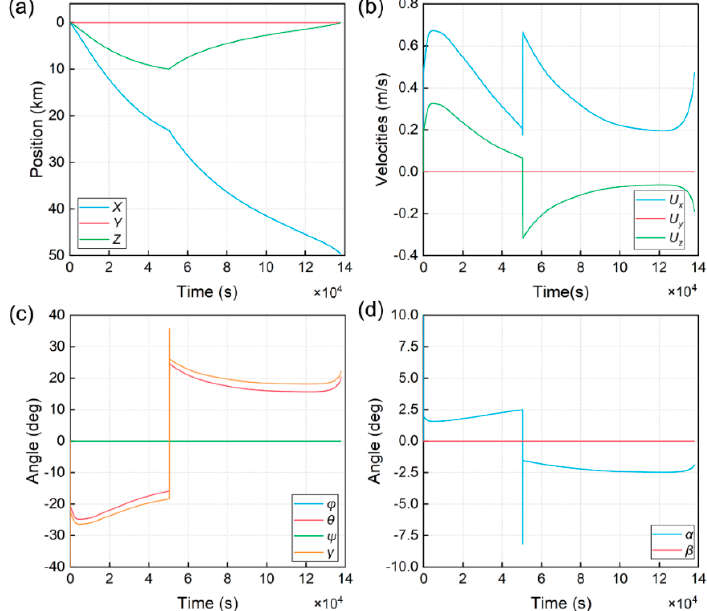
Figure 8. Simulation results in LR mode: ( a ) Position; ( b ) Velocities; ( c ) Euler angles and gliding angles; ( d ) Attack angle and side slip angle.